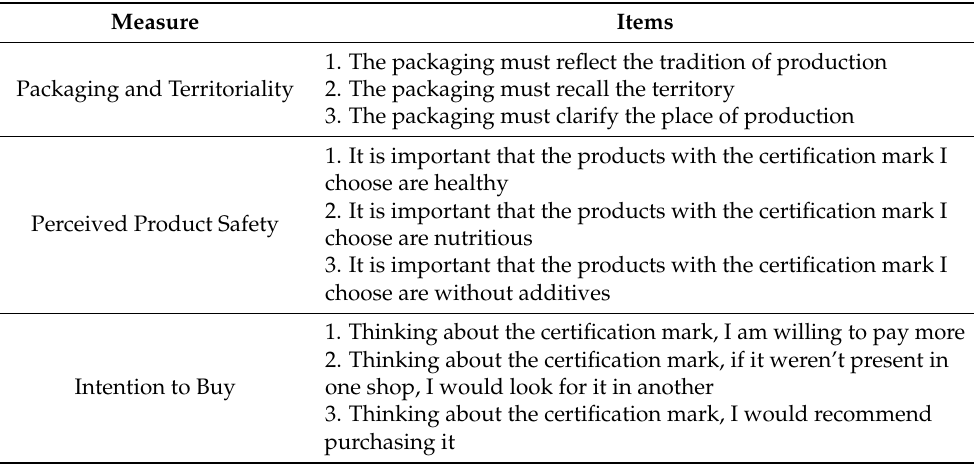
Table 1. List of measures and